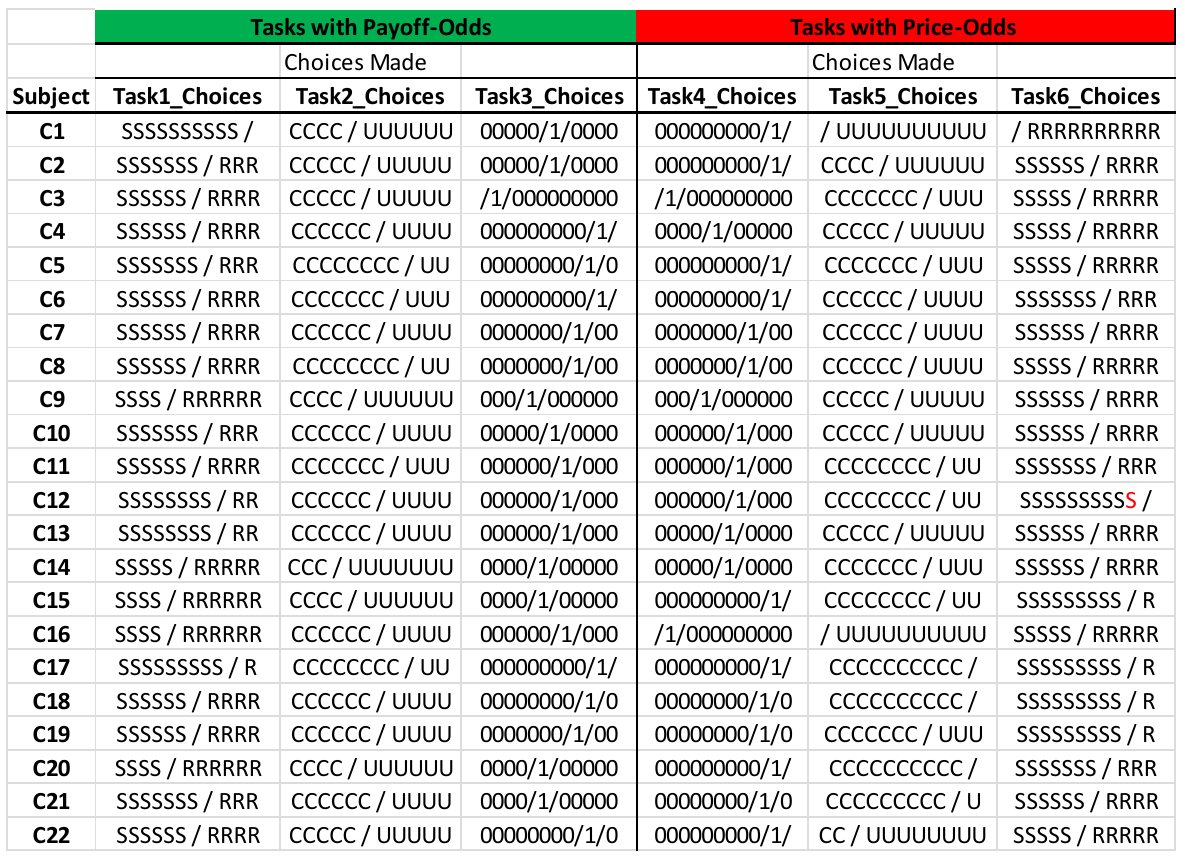
Figure A11. Individual lottery choice decisions—Session C. Table A12. Risk aversion classifications based on chosen options.